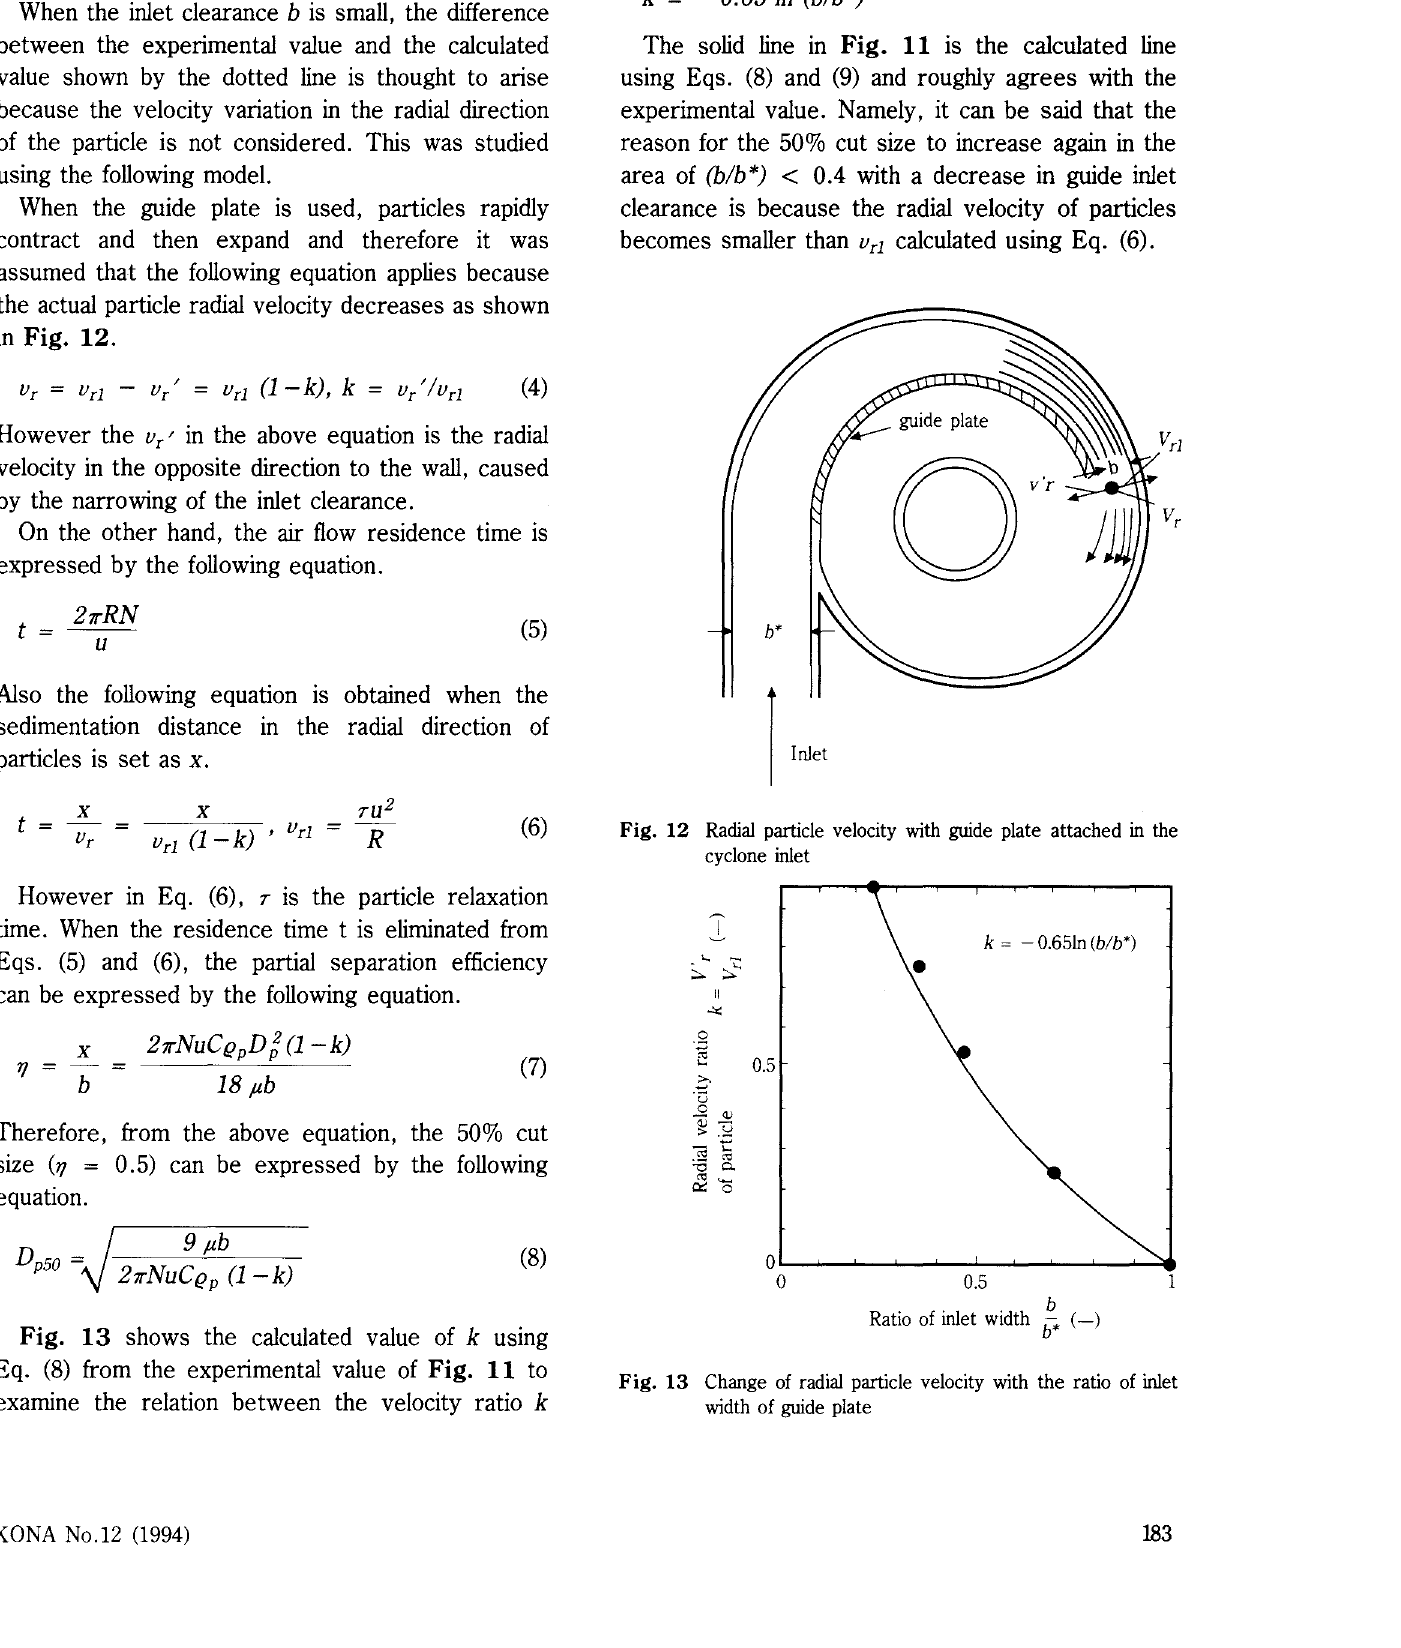
Fig. 13 Change of radial particle velocity with the ratio of inlet width of guide